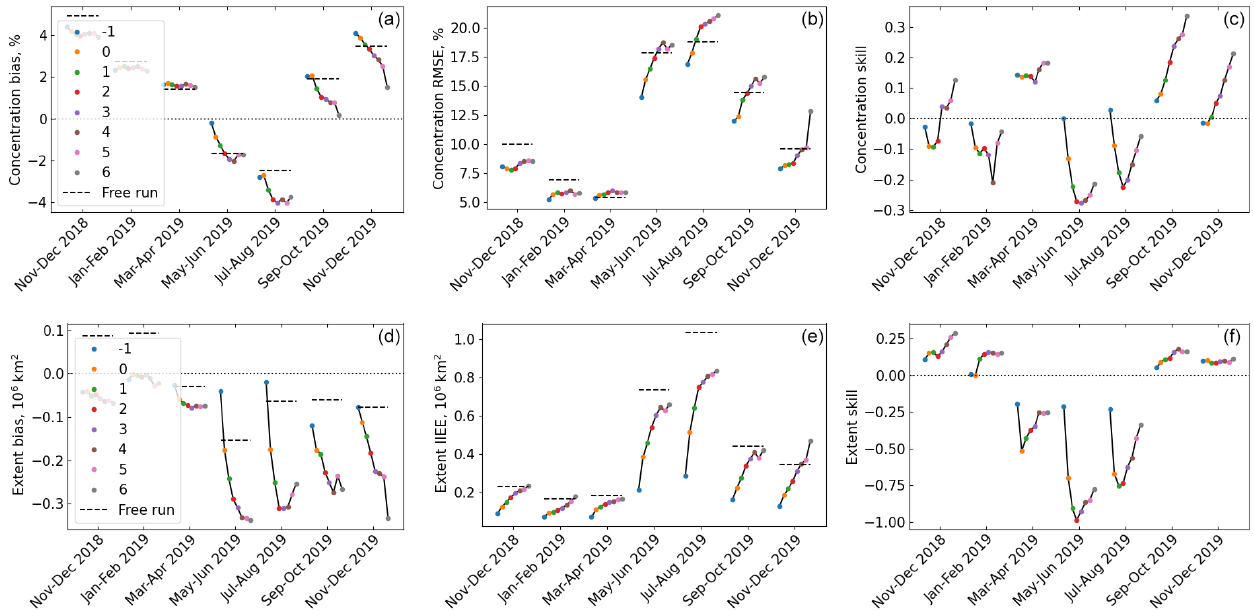
Figure 9. Two-monthly-averaged forecast errors grouped by lead time (lead times are indicated in the figure legends). The free run errors for the corresponding periods are plotted as dotted lines for reference on the bias and RMSE/IIEE plots. (a–c) Two-monthly-averaged bias, RMSE and forecast skill for concentration grouped by lead time. (d–f) Two-monthly-averaged bias, IIEE and forecast skill for extent grouped by lead